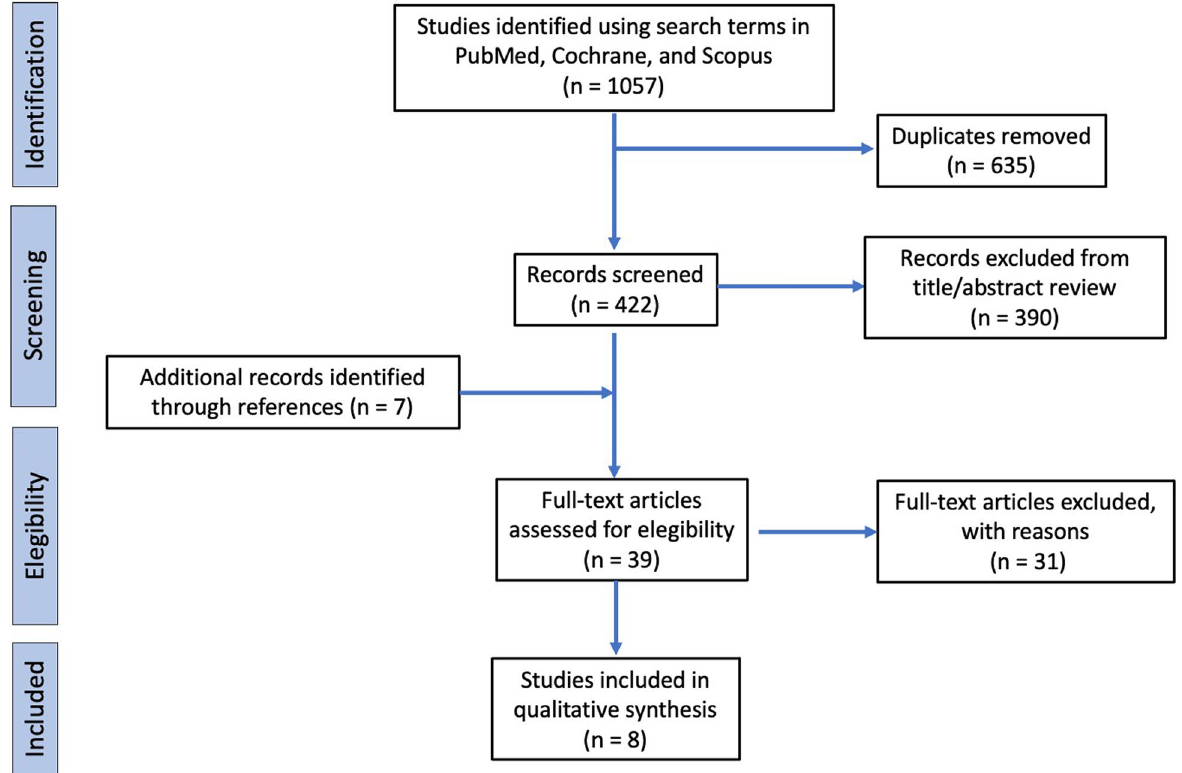
Fig. 3 PRISMA (Preferred Reporting Items for Systematic Reviews and Meta-Analyses) flow diagram of the paper selection for literature